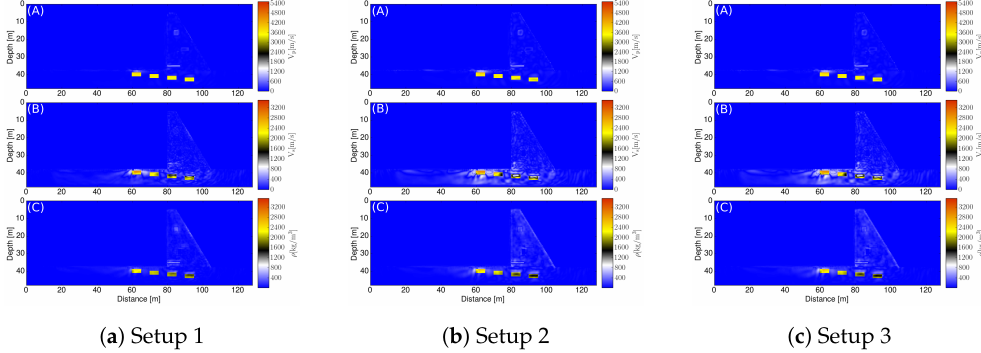
Figure 8. FWI residuals for acquisition setups as comparison with the true model for ( A ) V p , ( B ) V s and ( C ) ρ ,